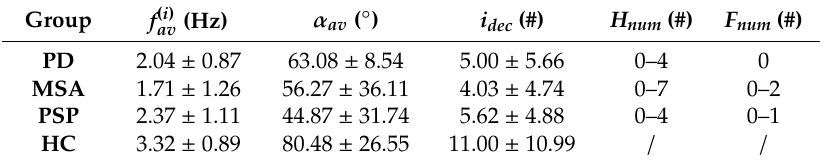
Table 2. Descriptive statistics (average ± st.deviation) for each feature and group of subjects.